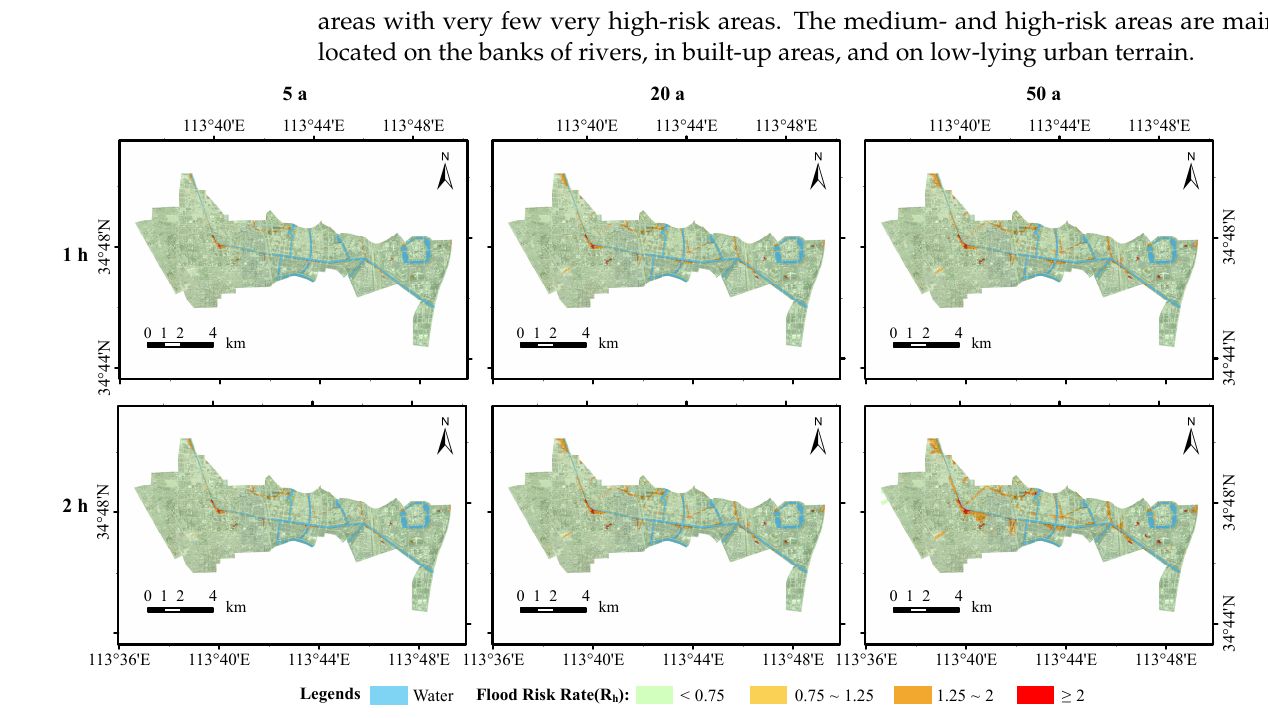
Figure 10. Inundation flood risk for different scenarios in the study area.